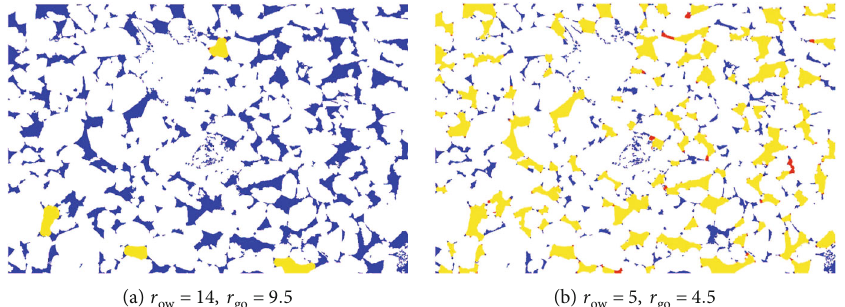
Figure 10: Three-phase fl uid con fi gurations for two gas invasion processes originating from di ff erent initial oil and water saturations in a weakly water-wet spreading system. The gas-oil and oil-water capillary pressure radii are given in pixel lengths. Yellow region: gas; red region: oil; blue region: